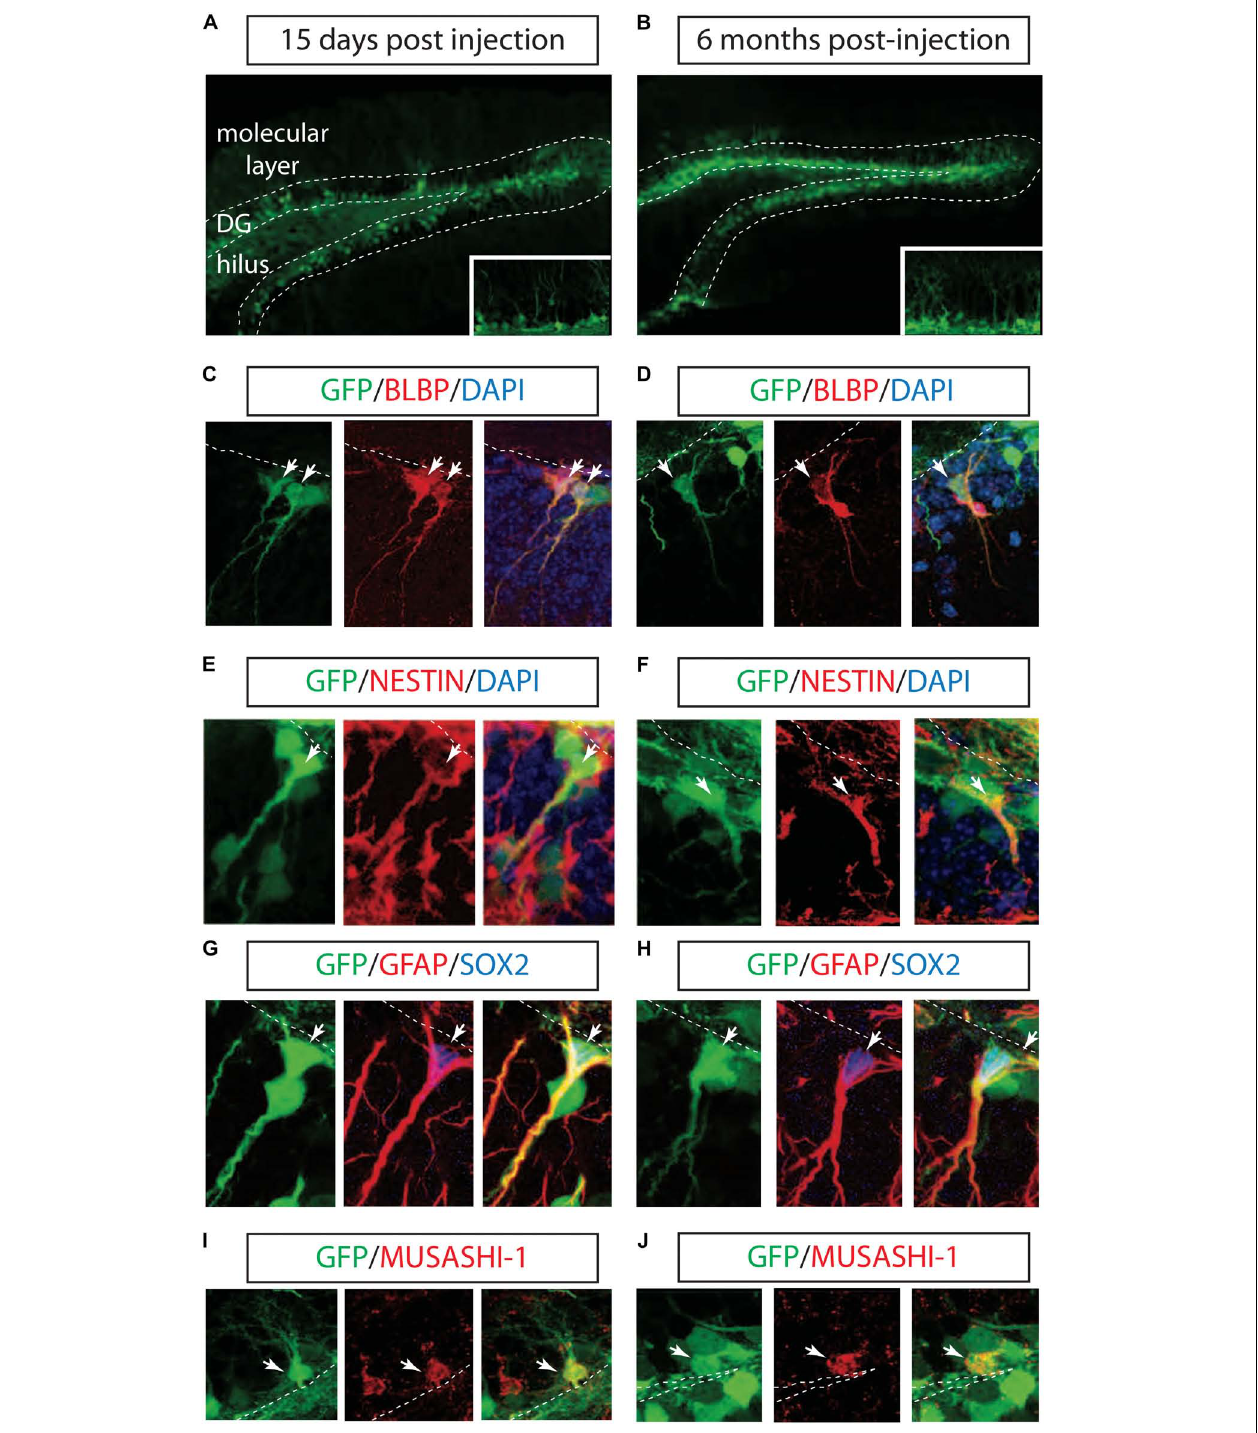
FIGURE 1 | Long-term marking of hippocampal NSCs by LV PGK-GFP. LV PGK-GFP was unilaterally injected into the hippocampal DG; brain sections were analyzed 15 days (A) and 6 months (B) later. GFP expression was evident in the DG at both time points. A higher magnification view is displayed in insets (A,B) . GFP-expressing cells co-labeled with NSCs markers such as BLBP (C,D) , NESTIN (E,F) , SOX2, GFAP (G,H) , and MUSASHI-1 (I,J) (arrows). Note that some GFP-positive cells stained for SOX2 showed co-localization with radial glial cell markers such as GFAP in their processes (G,H) . DG, dentate gyrus; SGZ is marked with dotted